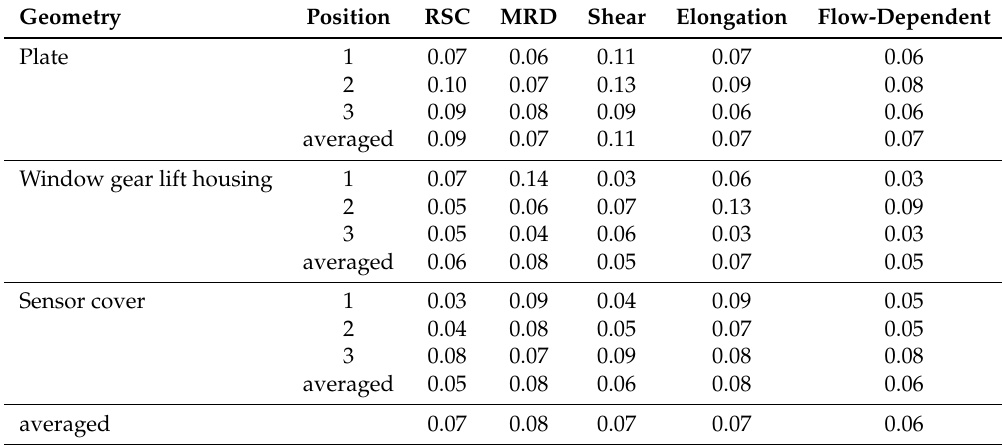
RMSD values between the experimental and simulated fiber orientation tensor in different